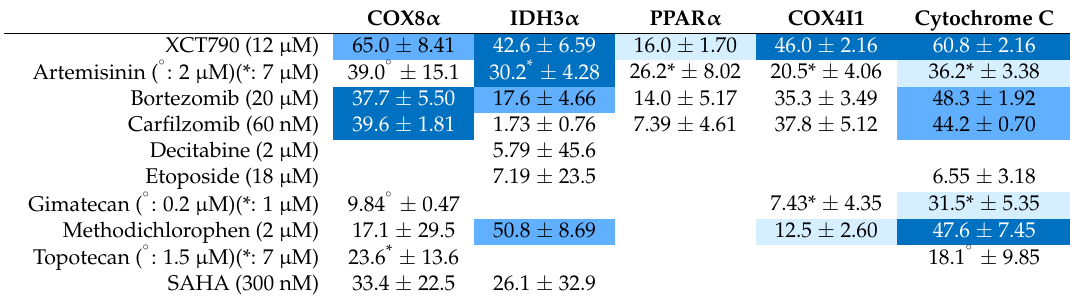
Figure 4. Assay heatmap of pesticide ERR α antagonists. The thirteen potential ERR α antagonist pesticide compounds were screened, and their activity outcome in 15 antagonist assays (AR-HEK293, AR-MDA, CAR-HepG2, ER-HEK293, ER-MCF7, ER β -HEK293, ERR-HEK293, FXR-HEK293, TRE-GH3, PGC/ERR-HEK293, PPAR γ -HEK293, PR-HEK293, RAR-C3H10T1/2, ROR γ -CHO, ShhGli1-3T3), 2 agonist assays (Nrf2/ARE-HepG2 and p53-HCT-116), and the MMP-HepG2 assay is displayed. Table 3. Percent inhibition of mRNA gene expression of antineoplastic agents.